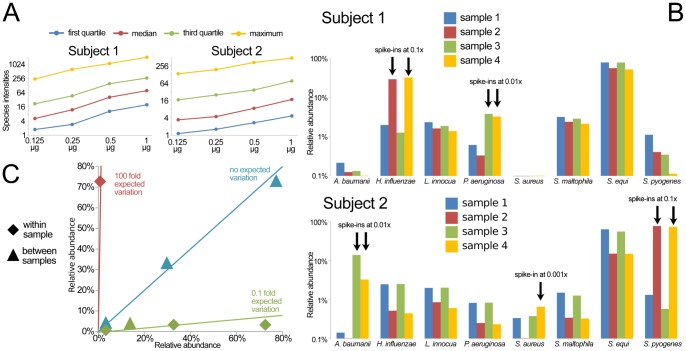
Application of the BactoChip to the oral microbiome detects native Streptococcus spp. and correctly identified the introduced spike-in species.A) Species-level averaged intensities linearly correlate with the total measured DNA in the range 0.125–1.000 µg. B) BactoChip detected the presence of Streptococcus equi in the saliva samples of both subjects at abundances higher than 50%. The introduced spike-ins for five different species at different abundances (from about 0.1% to 10% of the total community) were successfully identified in all cases with accurate distinction between different Streptococcus species. Only the species with a relative abundance greater than 1.5% in at least one sample are reported. C) Quantitative evaluation of the predictions for the introduce spike-ins looking in terms of fold change between the abundances within and between samples. All comparison showed strong consistency with the expected fold changes.